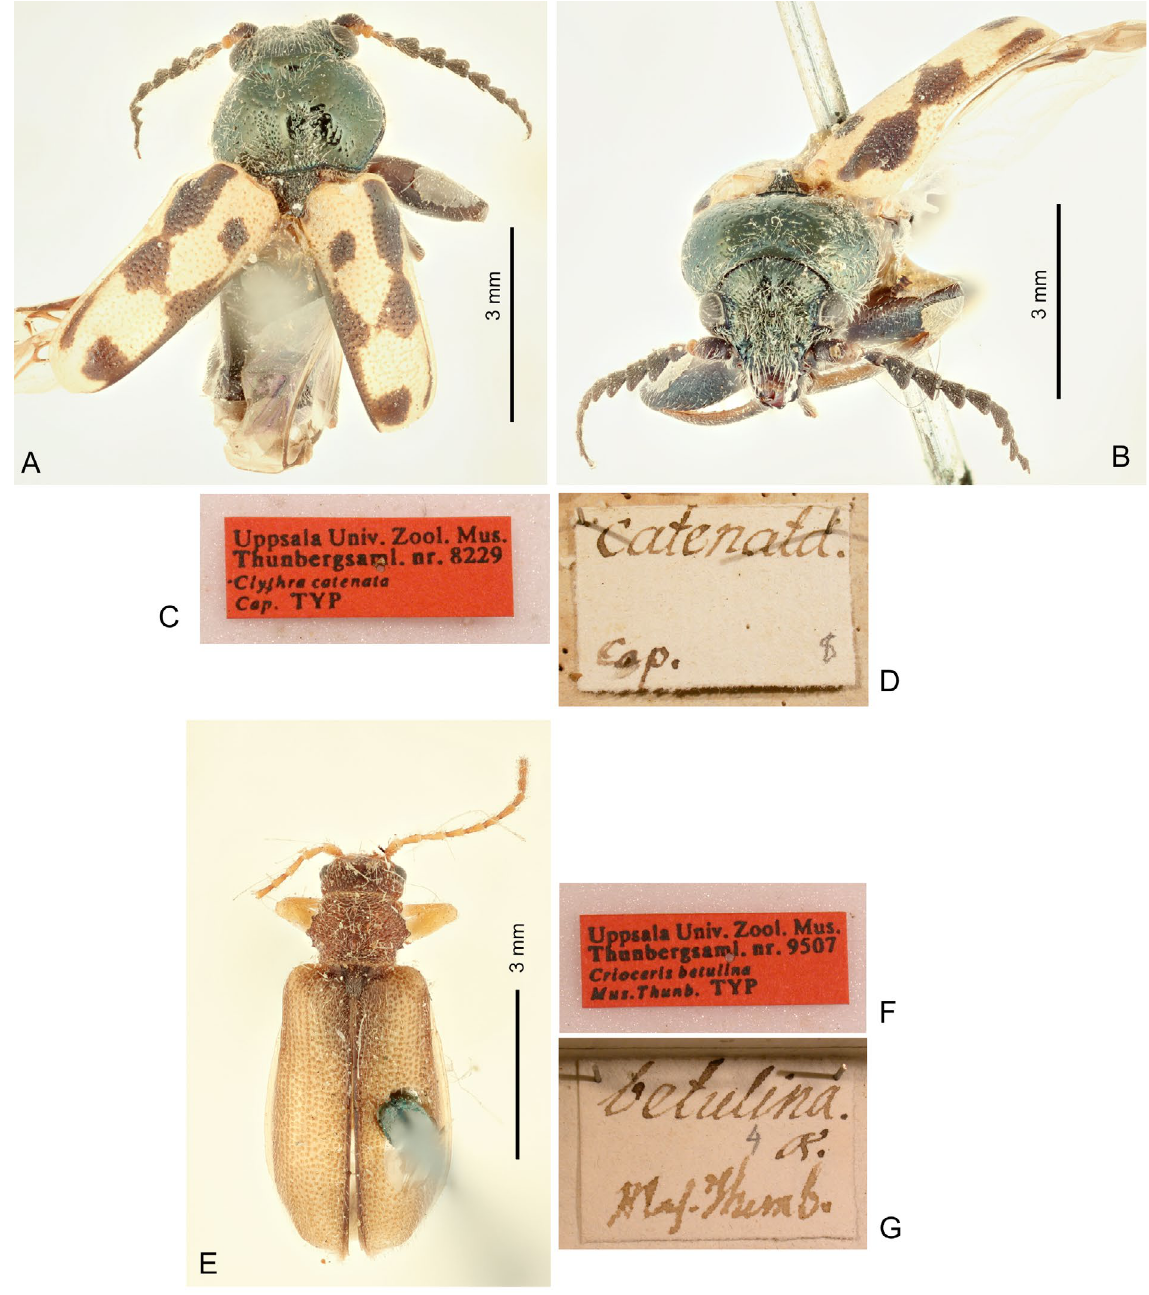
Fig. 13. A–D . Holotype of Teinocera catenata (Thunberg, 1821) comb. nov., ♂, 6.7 mm, UUZM. A . Dorsal view. B . Frontal view. C . Label. D . Box label. E–G . Syneta betulae (Fabricius, 1792) (syntype of Crioceris betulina Thunberg, 1787, unsexed, 6.0 mm, UUZM). E . Dorsal view. F . Label. G . Box